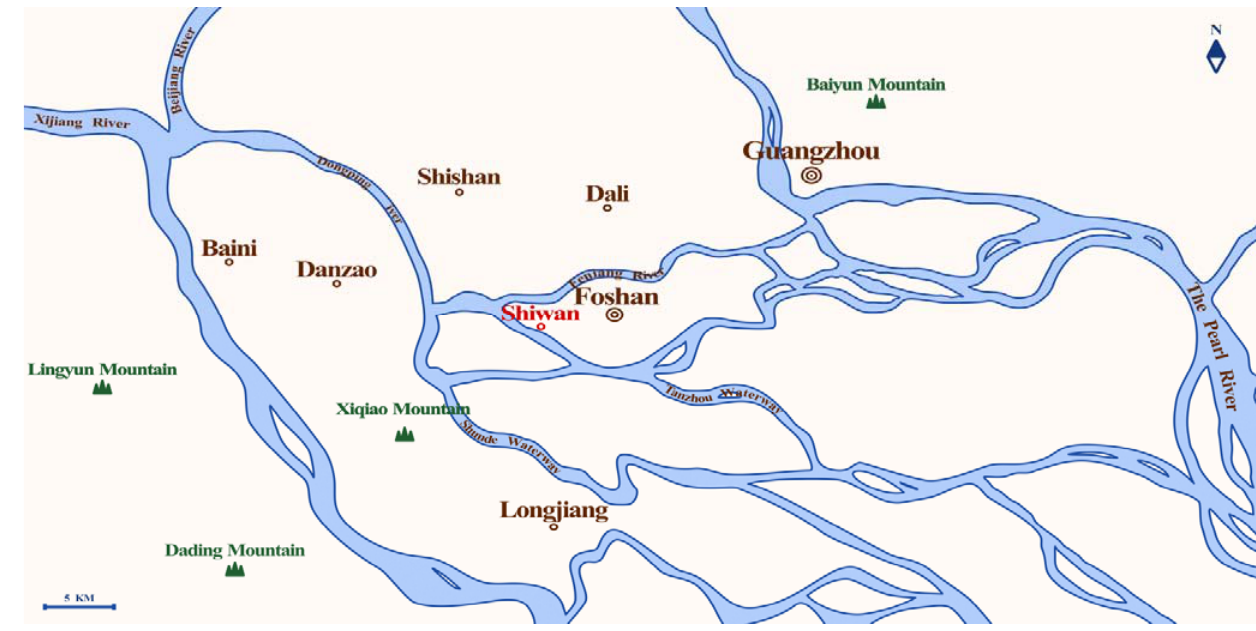
Figure 1. Geographical location of Shiwan.